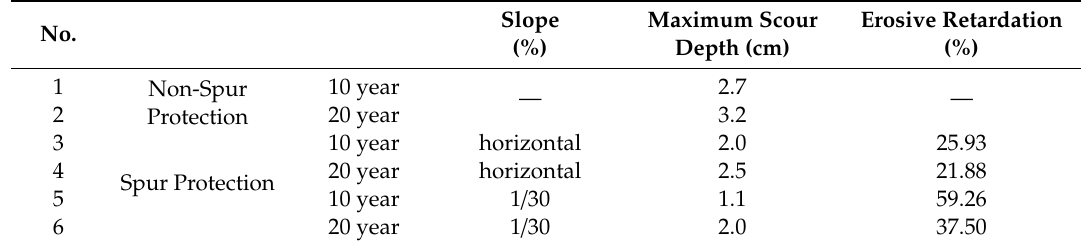
Table 3. The erosive retardation rate on the spur slope of horizontal and 1 / 30 with spur protection and normal bend scour